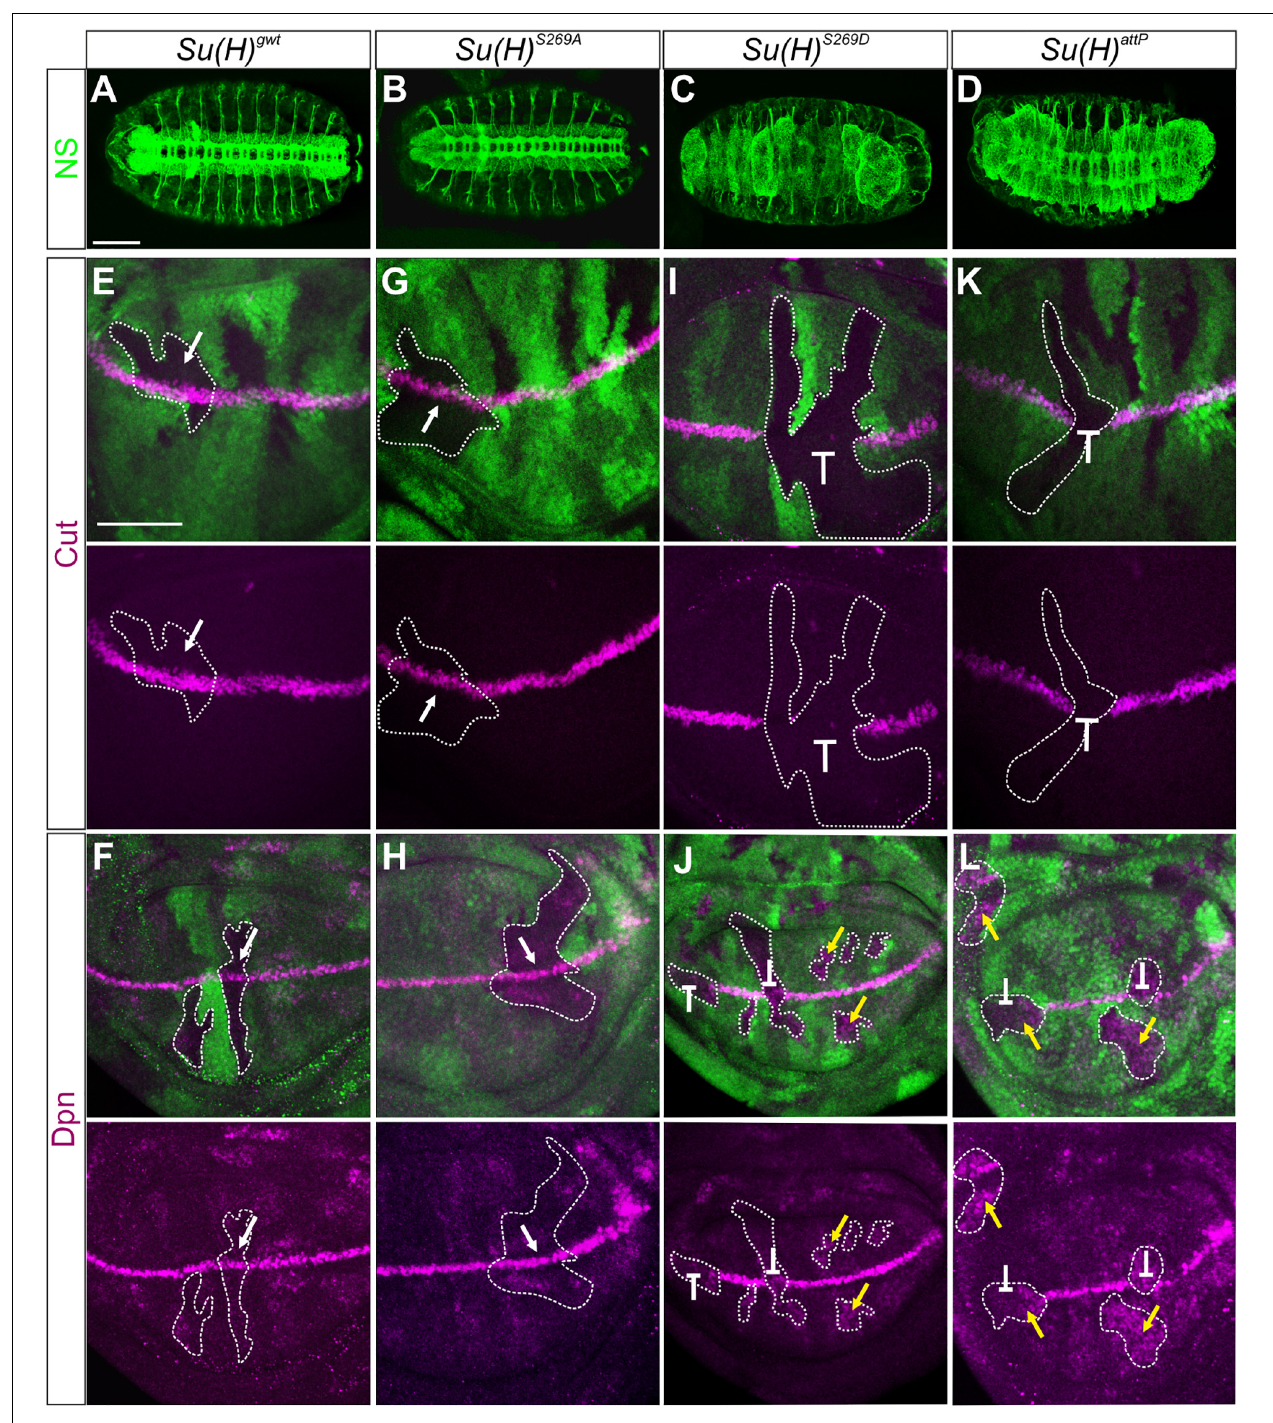
FIGURE 2 | Clonal analysis during embryonic and larval development. (A–D) Nervous system (NS) stained with anti-HRP (green) revealed a wild type pattern in homozygous Su(H) gwt (A) and Su(H) S 269 A mutant embryos (B) , whereas neural hyperplasia was observed in Su(H) S 269 D and Su(H) attP germline clones (C,D) . Scale bar represents 100 µ m. (E–L) Homozygous cell clones were generated in wing disks of Su(H) gwt (E,F) , Su(H) S 269 A (G,H) , Su(H) S 269 D (I,J) , and Su(H) attP (K,L) heterozygous animals. Expression of the Notch targets Cut ( E,G,I,K , magenta) and Dpn ( F,H,J,L , magenta) is shown. Homozygous mutant clones are marked by the absence of GFP (green; examples are outlined). In Su(H) gwt and Su(H) S 269 A clones, target gene expression is unaffected ( E–H , arrows). In contrast, Su(H) S 269 D and Su(H) attP mutant clones show a loss of Cut and Dpn expression at the d/v boundary ( I–L , repressive bar), whereas Dpn is de-repressed in mutant clones outside this region ( J,L , yellow arrows). Scale bar in panel (E) represents 50 µ m for all panels.